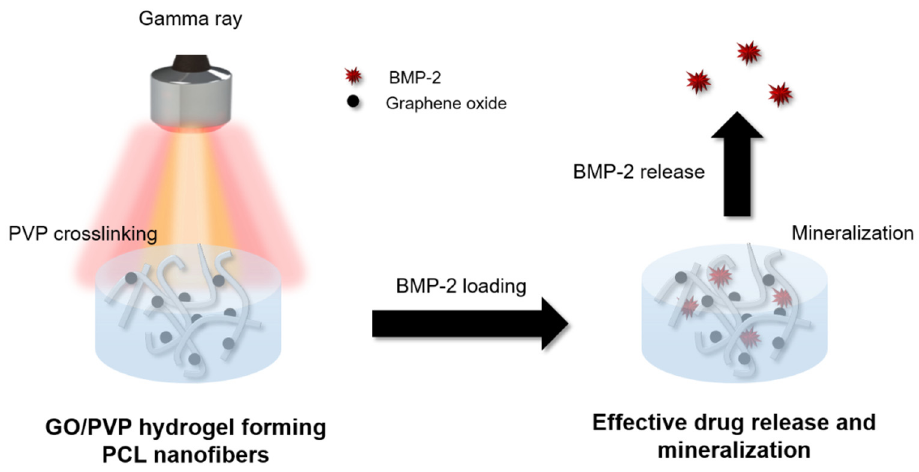
Figure 1. Schematic illustration of the preparation of the GO/PVP hydrogel forming PCL